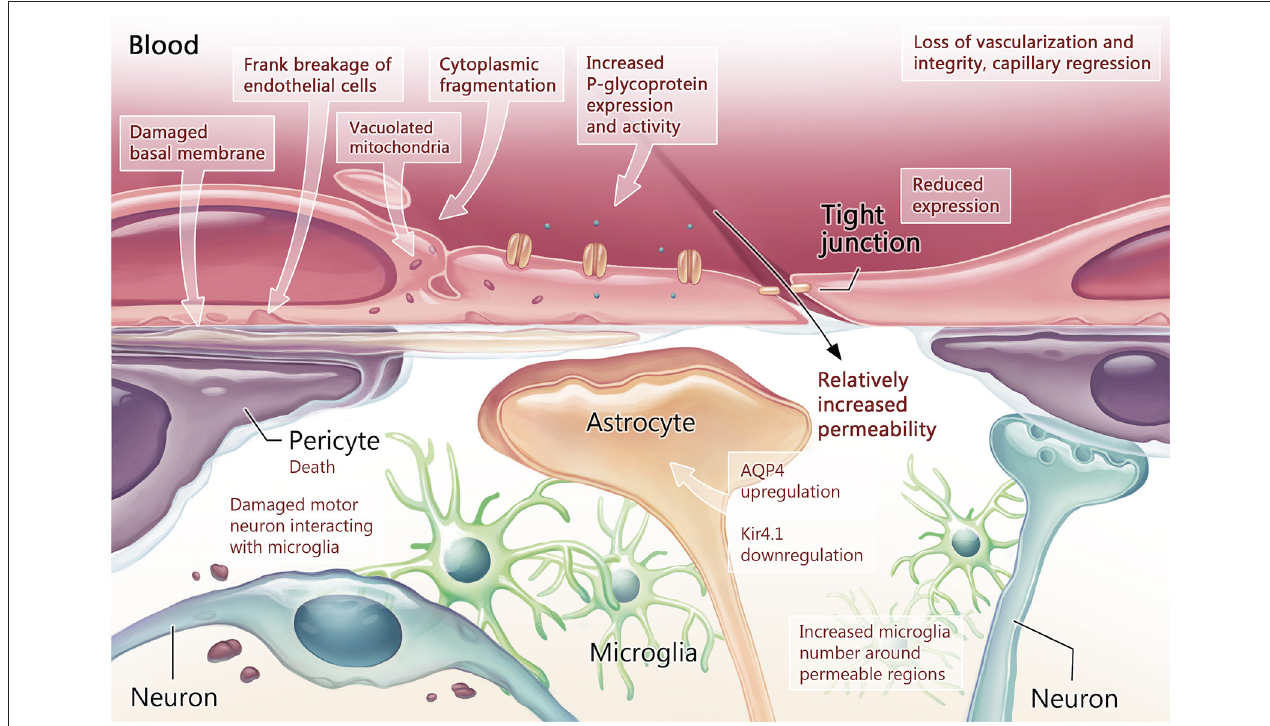
FIGURE 2 | Blood-CNS barrier structure and function in the symptomatic stage of ALS. Once measurable behavioral changes have occurred, the early loss of neurovascular unit integrity has progressed to loss of vascularization through capillary regression. Tight junction protein expression is measurably reduced in endothelial cells, while export proteins such as P-glycoprotein (P-gp) demonstrate increased expression and activity. Within endothelial cells, signs of damage manifest as vacuolated mitochondria and cytoplasmic fragmentation. Damage to the basement membrane is also present. These changes culminate as breakage of the endothelial cell lining. With increased blood-CNS-barrier (BCNSB) permeability, changes in the cellular- molecular environment of the CNS can be measured including pericyte death and increased neuroinflammation as microglia satellite to damaged motor neurons and permeable regions. Astrocytes manifest molecular changes in the form of aquaporin 4 (AQP4) upregulation and potassium channel (Kir4.1) downregulation, leading to dysregulation the perineuronal